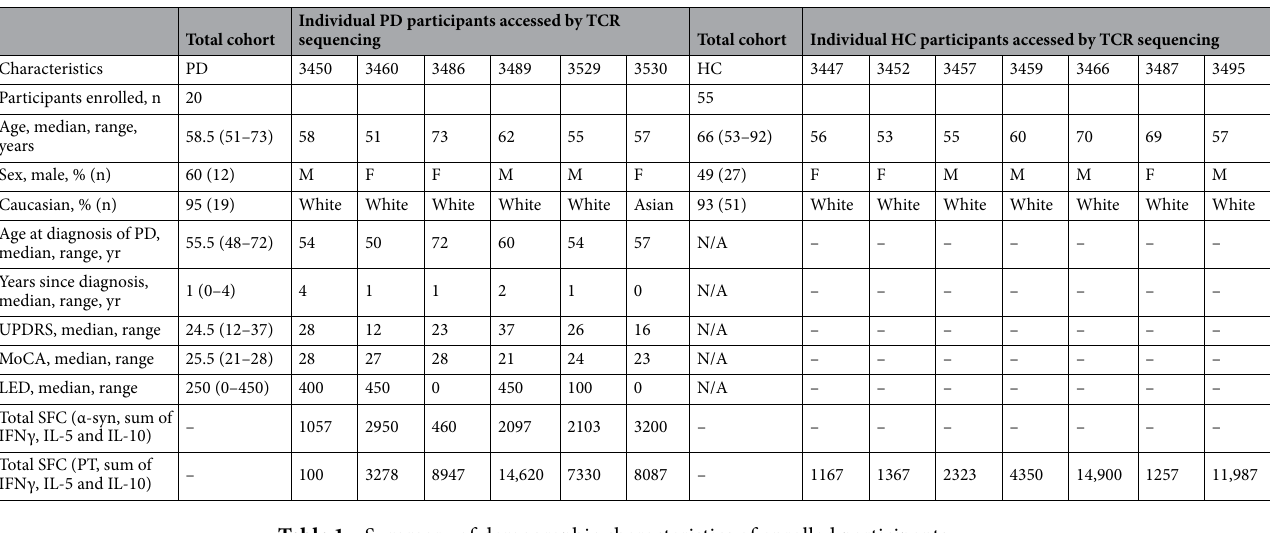
Table 1. Summary of demographic characteristics of enrolled participants.